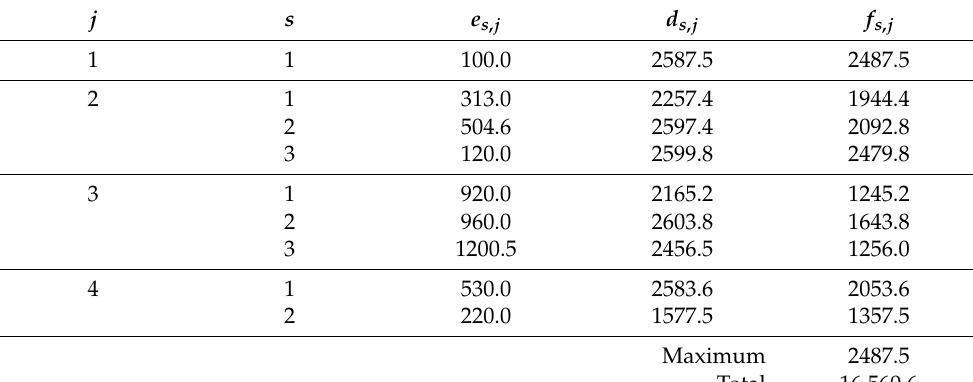
Table 5. Sublot flowtime related performance measure ( f max and f total